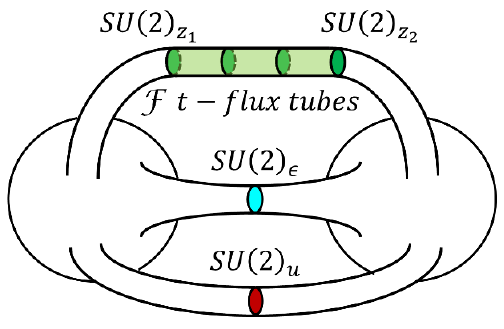
Figure 8 . An illustration of a genus g = 2 surface with additional t -(cid:13)ux. The surfaces is constructed by gluing together two trinions and F t-(cid:13)ux